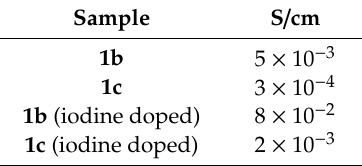
Table 3. Conductivity of the films using the 4-point probe method before and after iodine doping.